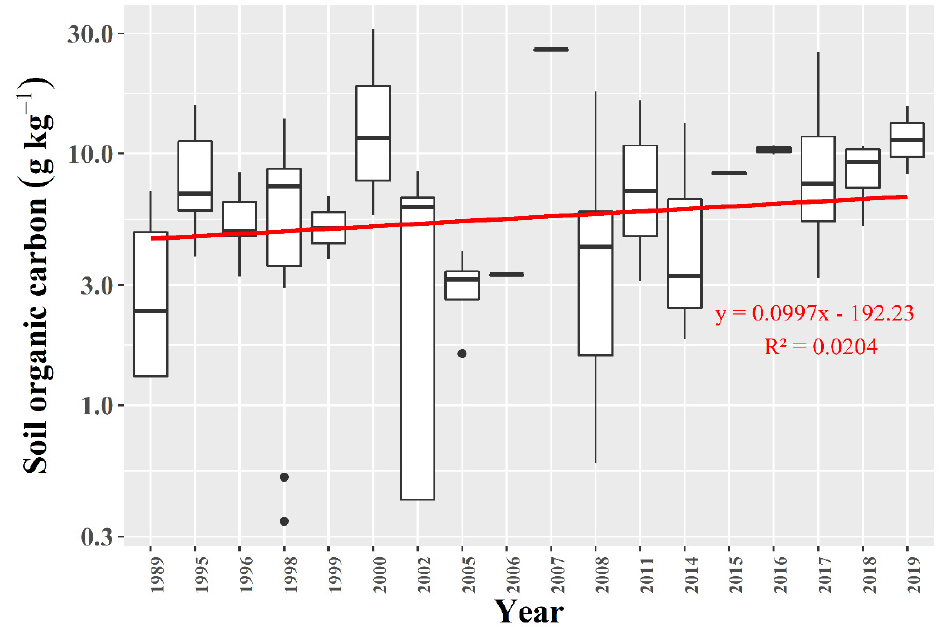
Figure 9. Overview on soil organic carbon (g kg − 1 ) observed data from 1989 to 2019 in Northeast Thailand ( n = 89) (within the range of 0–40 cm depth) [41,49–70].